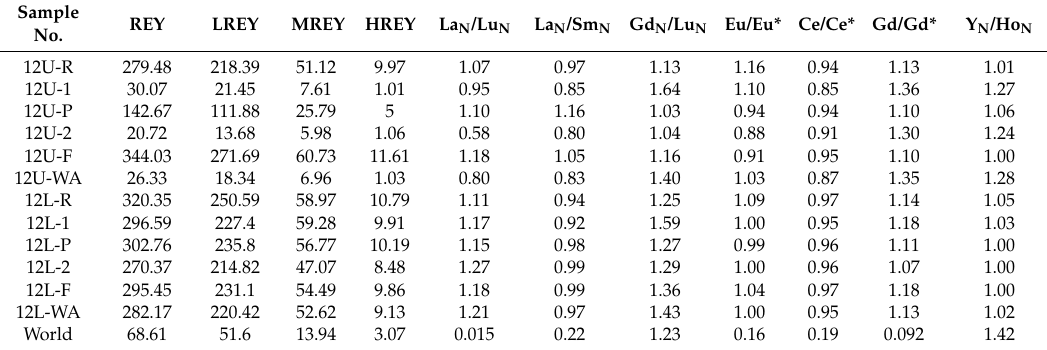
Table 4. REY parameters of coals, partings, roofs, and floors from the Meitian Mine. Sample